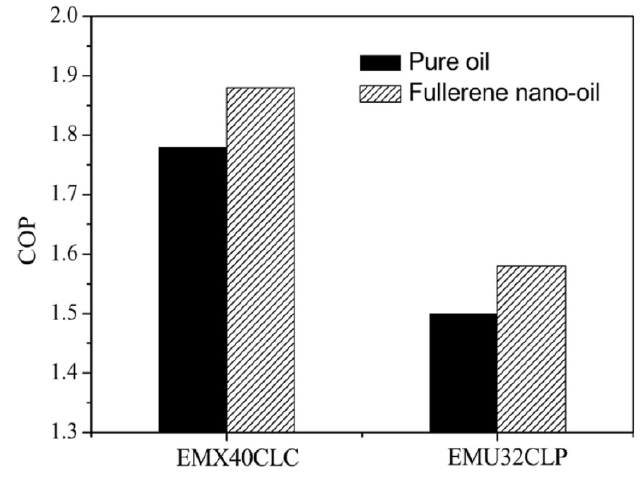
Figure 14. The results of compressor performance testing on COP [40].